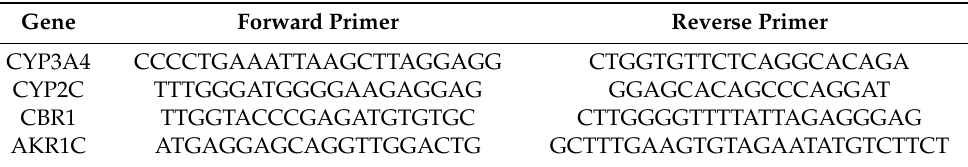
Table 2. List of primers used for RT-qPCR analysis of the selected genes.